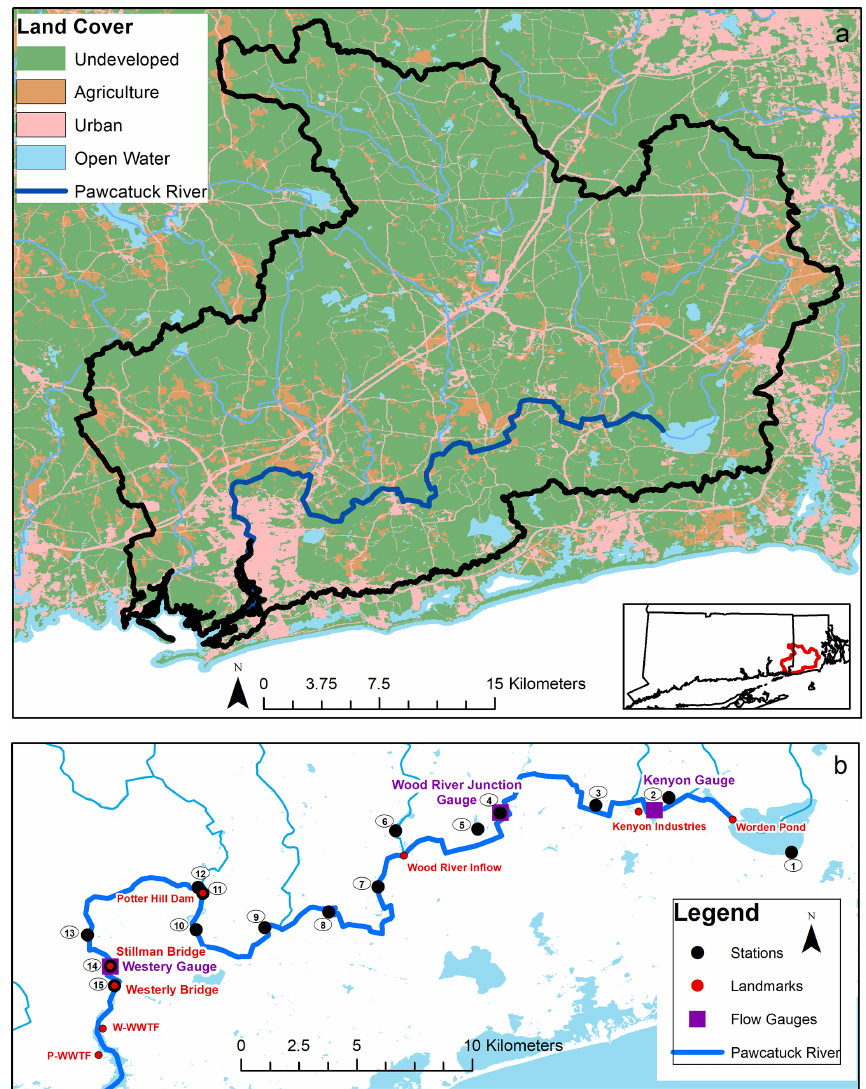
Figure 1. (a) Map of the Pawcatuck River watershed and associated land use (URIEDC_RIGIS, 2019; US Geological Survey, 2011). (b) Map of sampling locations, landmarks including the Westerly and Pawcatuck wastewater treatment facilities (WWTFs), and river discharge gauges along the Pawcatuck River (US Geological Survey, 2005; US Census Bureau,